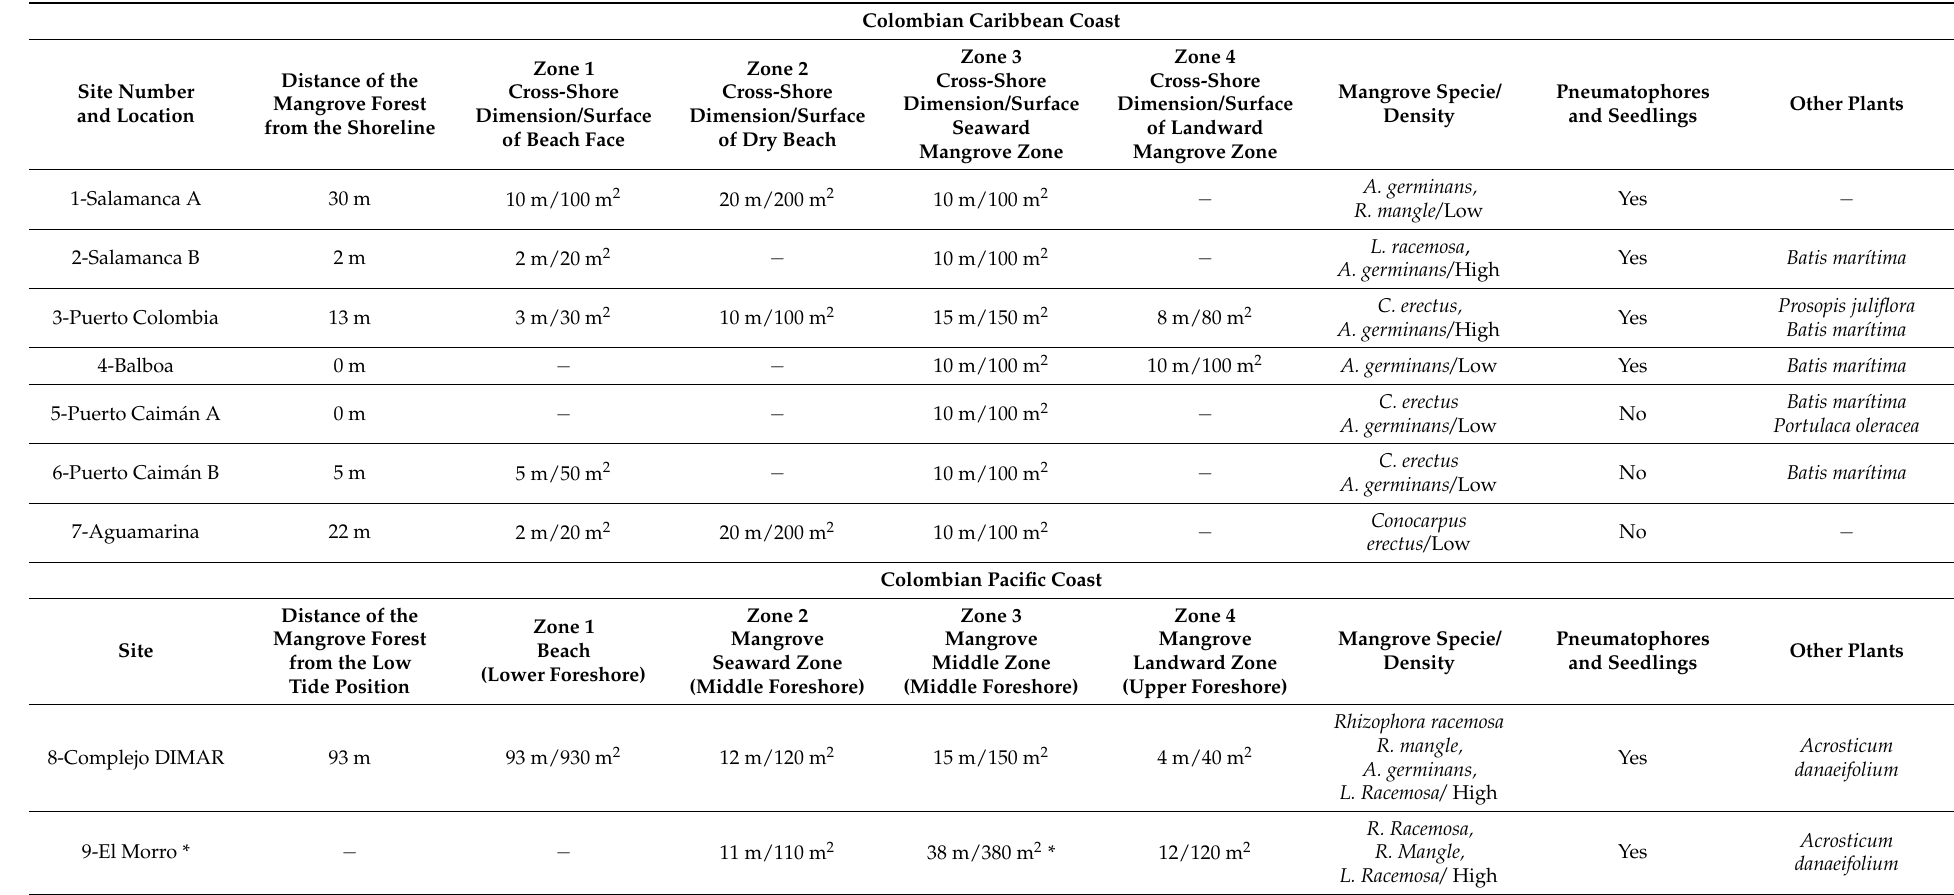
Table 1. Characteristics of beaches and mangrove forests at each sampled